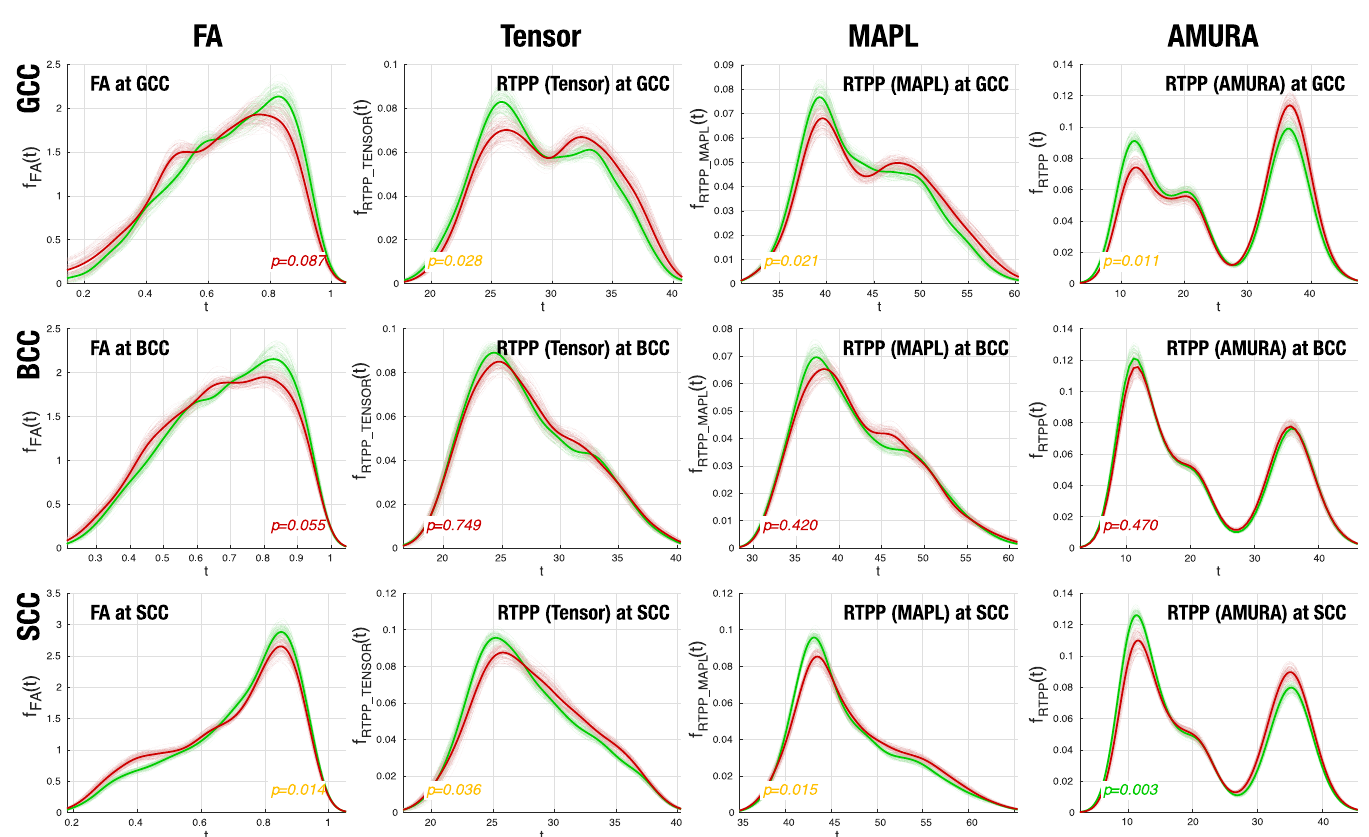
Fig 4. PDFs of RTPP computed from either the tensor model, MAPL, or AMURA (plus the FA) and within each of GCC, BCC, or SCC. (Red) Patients; (Green) Controls. (Dashed line) Bootstrap PDF from 100 iterations with 15 subjects each; (Solid line) Global PDF for all controls/patients. The p -values are referred to the t -tests reported in Table 7.